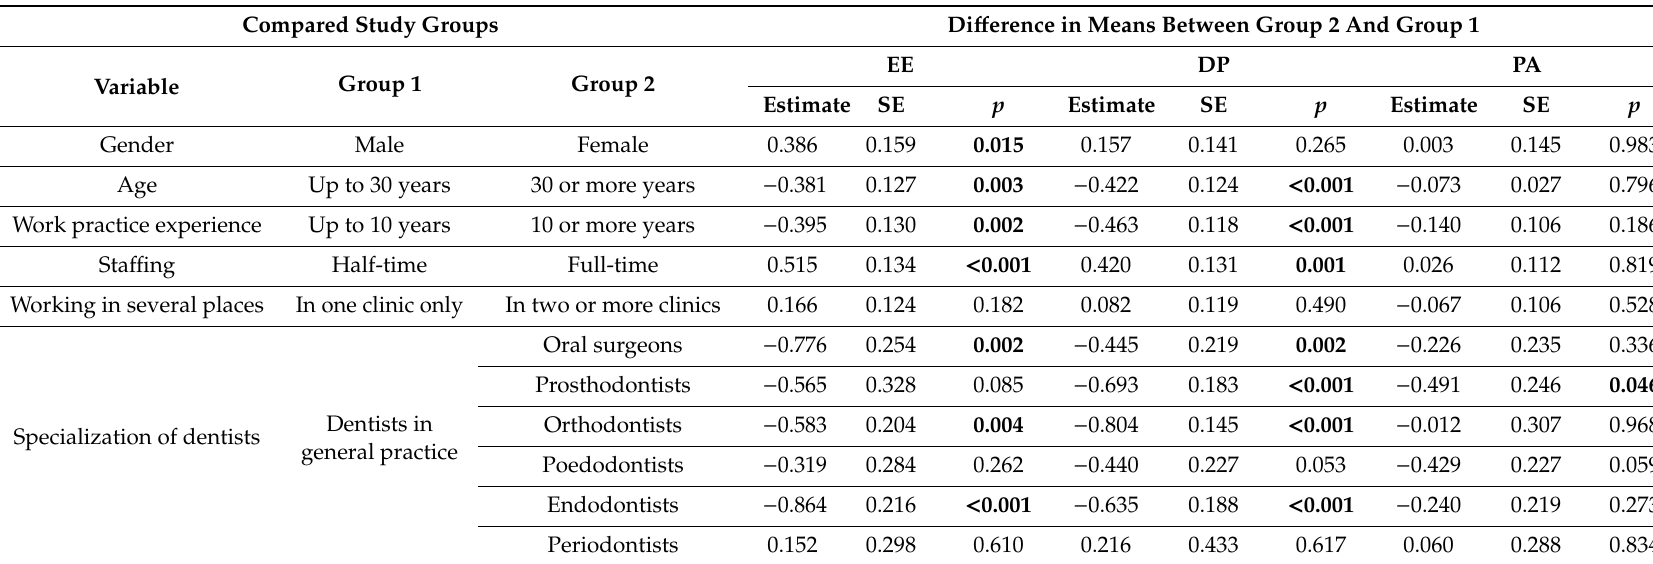
Table 6. Comparison of mean values of the Maslach burnout inventory common factors between demographic and workload groups ( N =